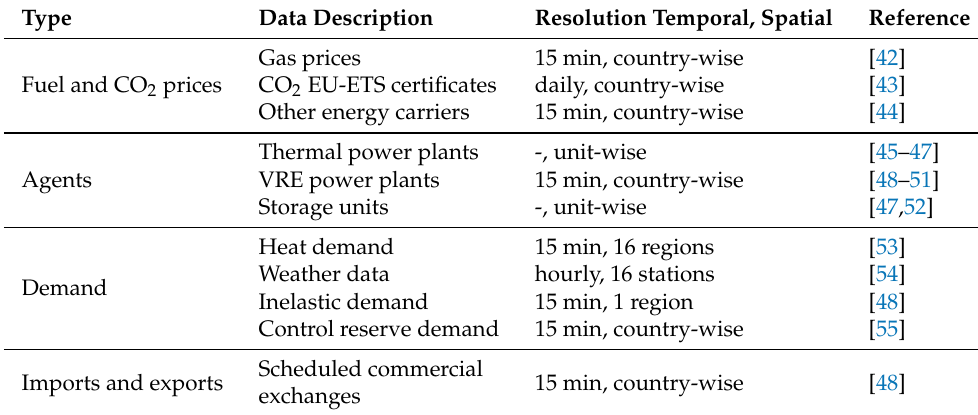
Table 2. Data sources used for the